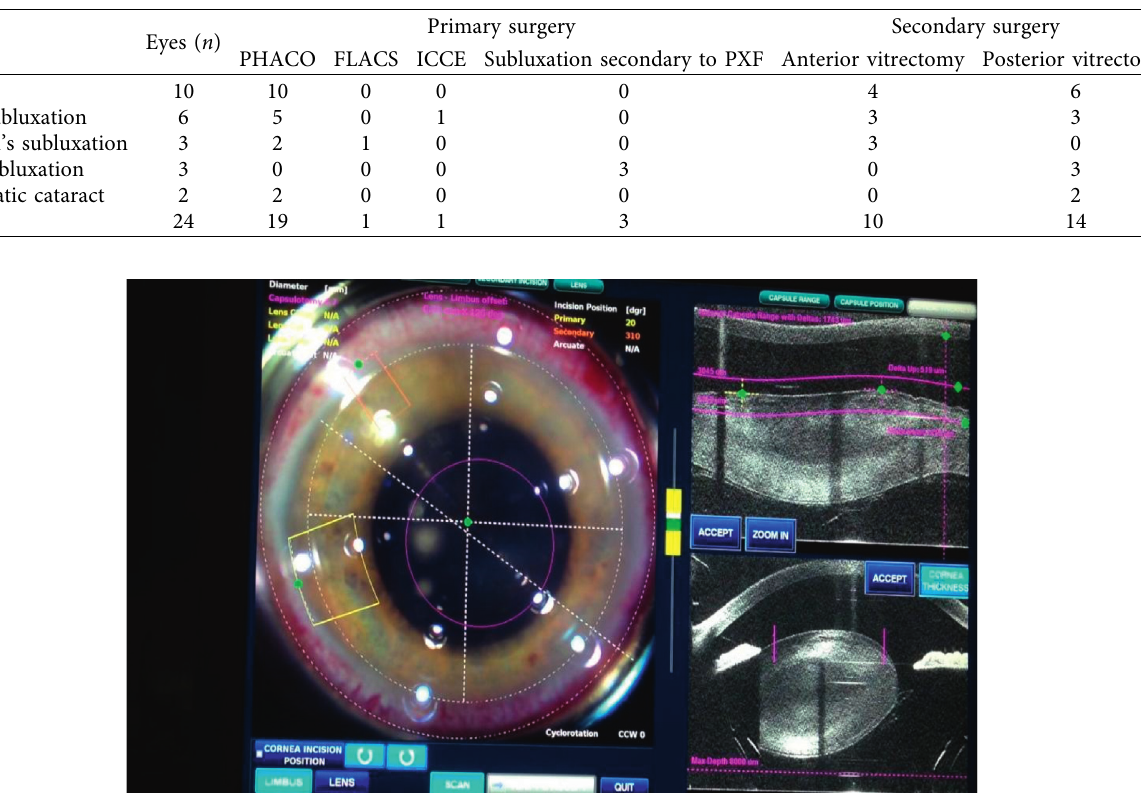
Table 2: Primary or secondary type of surgery.